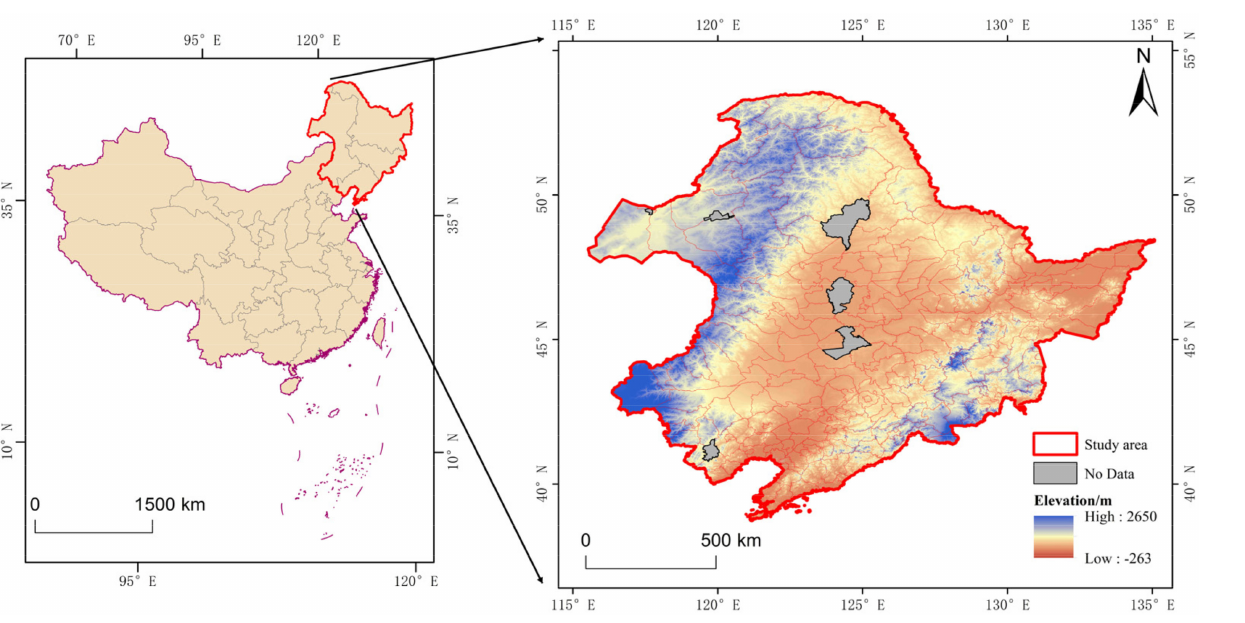
Figure 1. The spatial location of the study